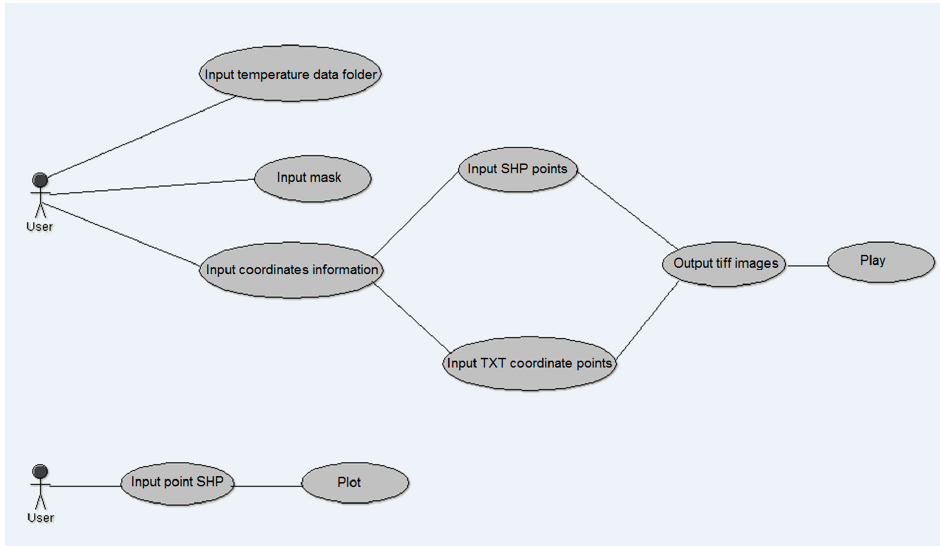
Figure 4. User case diagram of a GIS-ECOAL application.